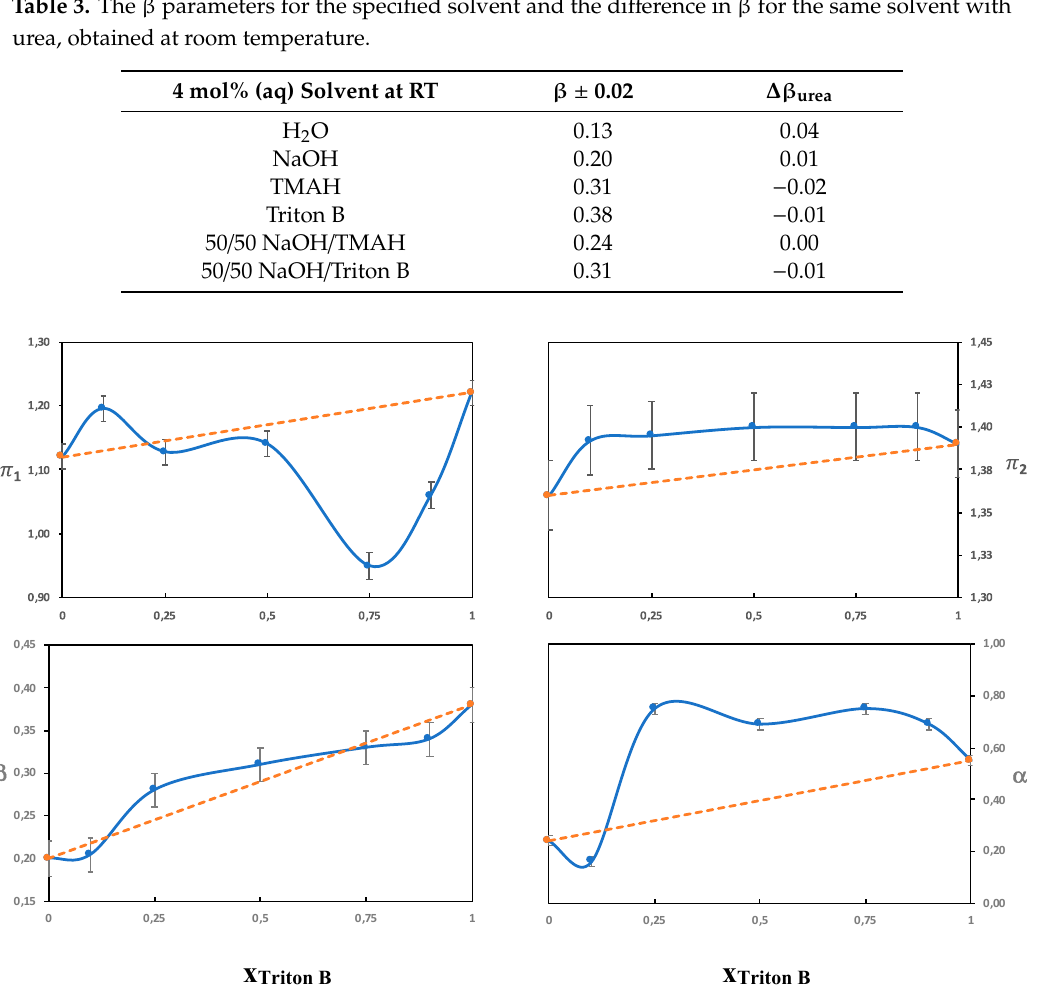
Figure 6. The Kamlet ‐ Taft parameters as a function of the molar fraction of Triton B in solutions of 4 mol% NaOH/Triton B.